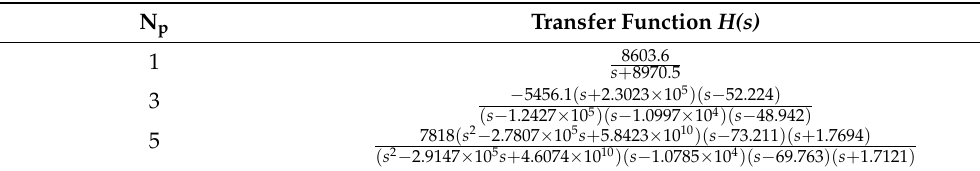
Figure 8. ( a ) Bode magnitude plot of the phase-modulation efficiency, and ( b ) phase delay Bode plot; the primary single pole was located near 1.43 kHz. Table 1. Transfer functions in s-plane found by using a generalized Maxwell model to represent the experimental results depending on the number of poles ( N p )